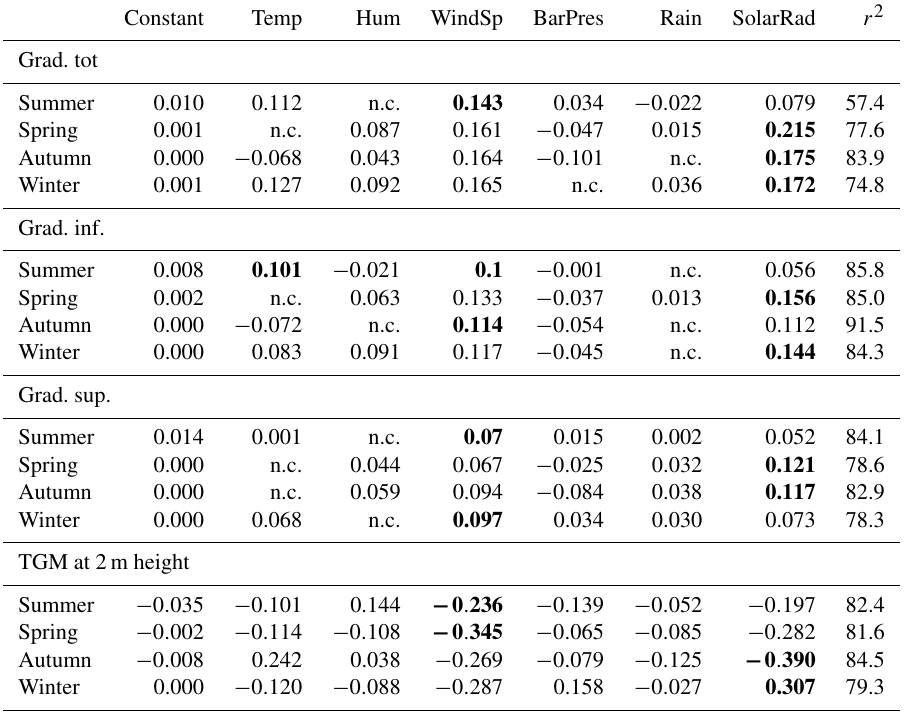
Table 3. Predictor coefficients resulting from a multiple linear regression analysis (MLRA). The main predictors by season are shown in bold type. Abbreviations: Temp: outside temperature; Hum: outside humidity; WindSp.: wind speed; BarPres: barometric pressure; SolarRad.: solar radiation; n.c.: not considered in the